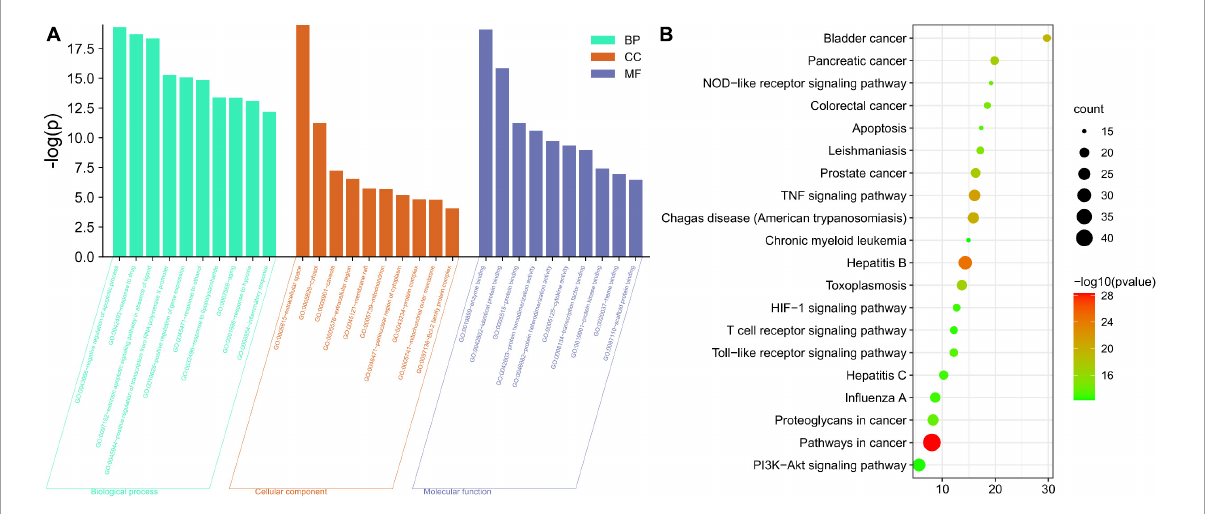
FIGURE8 Diagram of enrichment analysis results. (A) Gene Ontology enrichment analysis for key targets (top 10 were listed). (B) KEGG pathway enrichment analysis of key targets (top 20 were listed); the abscissa label represents fold enrichment of pathways.